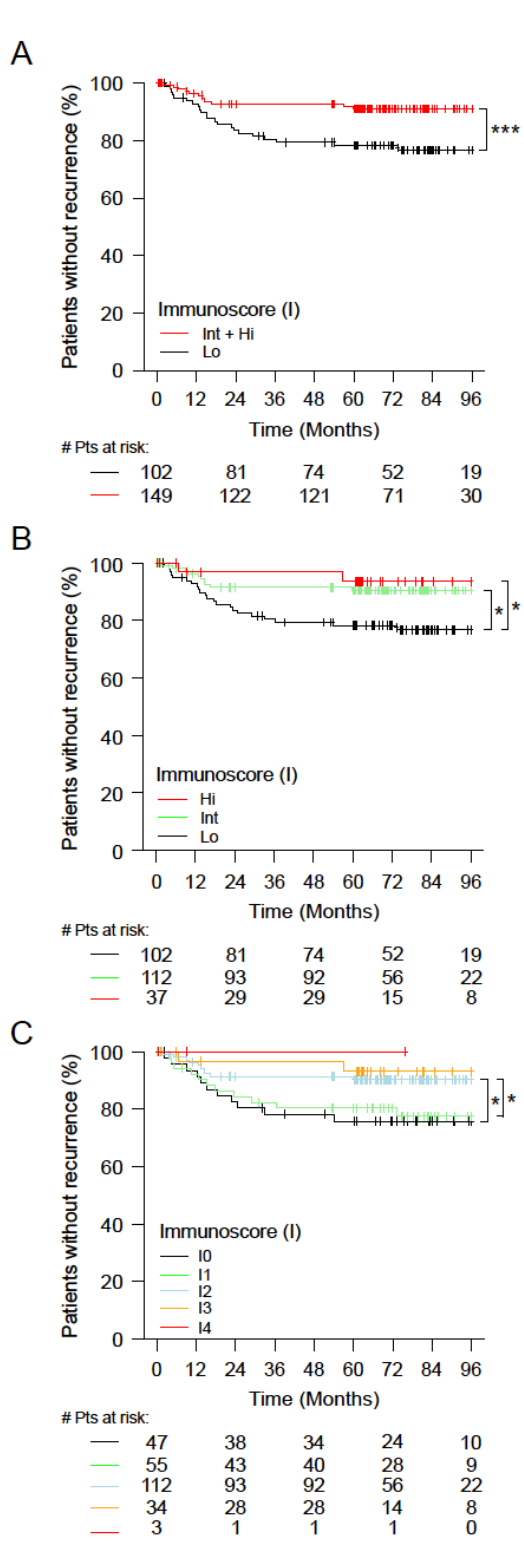
Figure 4. The outcomes of stage II colon cancer patients according to Immunoscore. ( A – C ) Kaplan– Meier curves of Immunoscore for stage II patients are shown for time to recurrence (TTR). ( A ) Two Immunoscore categories: Lo (0–25%, black) and Int+Hi (>25–100%, red). ( B ) Three Immunoscore categories: Lo (0–25%, black), Int (>25–70%, green), and Hi (>70–100%, red). ( C ) Five Immunoscore categories: I0 (0–10%, black), I1 (>10–25%, green), I2 (>25–70%, azure), I3 (>70–95%, orange), and I4 (>95–100%, red). Significant log-rank p -values are marked as *** p < 0.005 and * 0.01 ≥ p < 0.05.